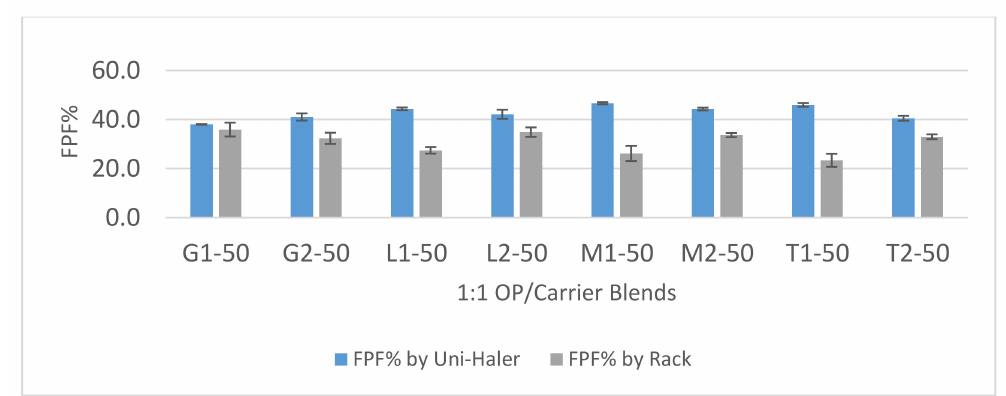
Figure 5. Fine-particle fraction (FPF)% chart of 1:1 OP / diluent blends aerosolized by the UNI-haler and the Rack. Blends are arranged according to diluent grade from left to right; micronized glucose (G1), milled glucose (G2), micronized lactose (L1), milled lactose (L2), micronized mannitol (M1), milled mannitol (M2), micronized trehalose (T1), and milled trehalose (T2). Error bars based on calculated standard deviation from mean ( n = 3).